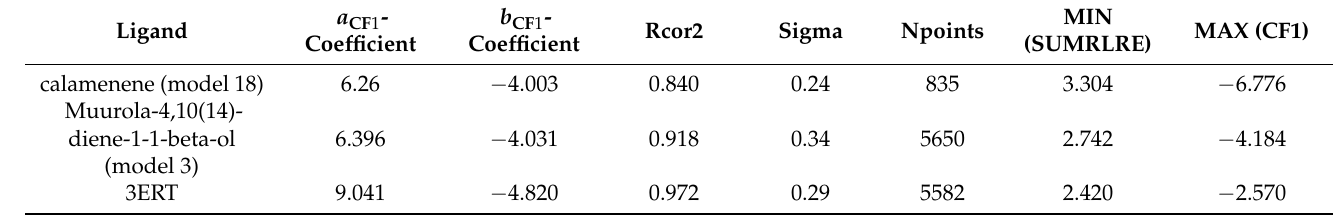
Table 5. Complementarity parameters of docked and experimental (3ERT) “enzyme–ligand”